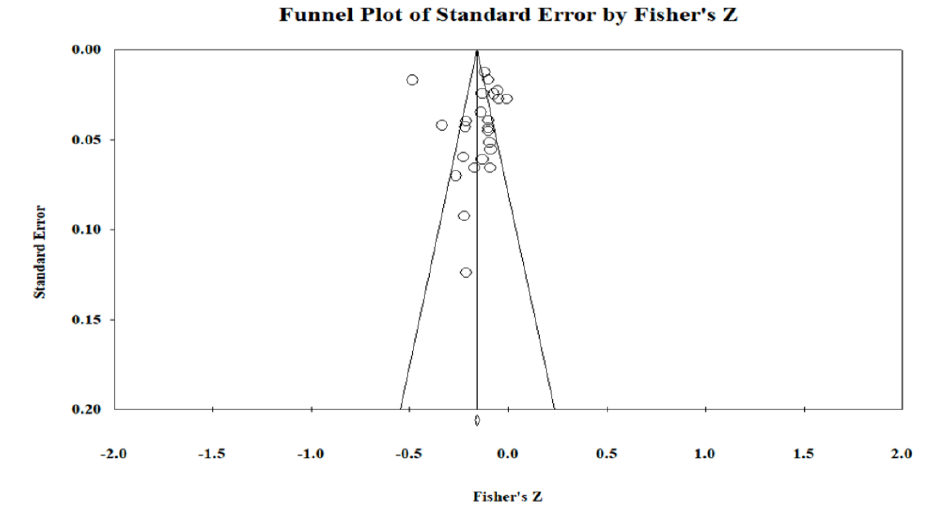
Figure 3. Result of funnel plot publication bias analysis.